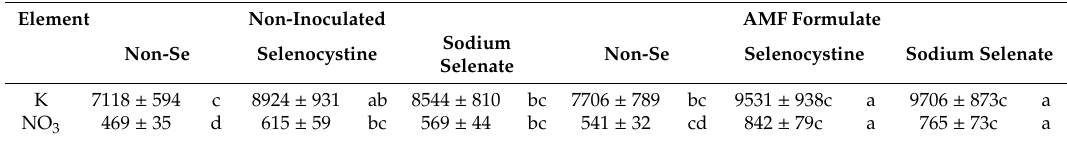
Table 4. Interaction between microorganism inoculation and selenium treatment on shallot bulb macro-elemental composition (mg · kg − 1